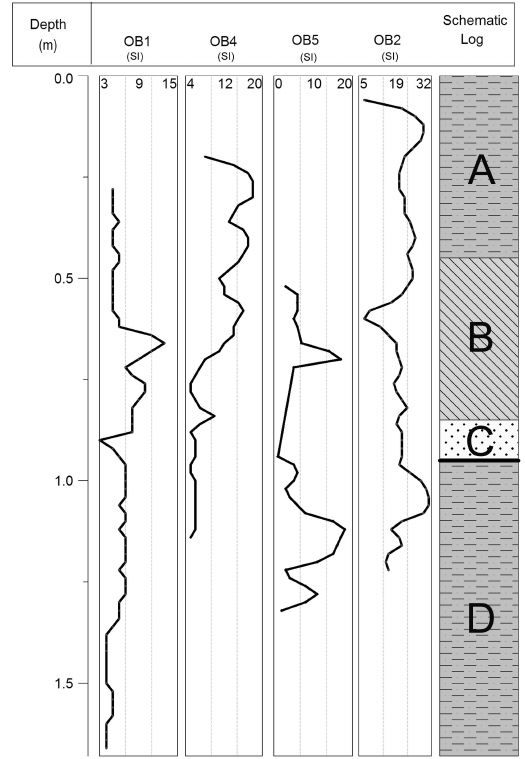
Fig. 4. Magnetic susceptibility results obtained for cores from Lagoa de ´Obidos (please note different range of values for each core) – for core locations please check Fig. 1e.